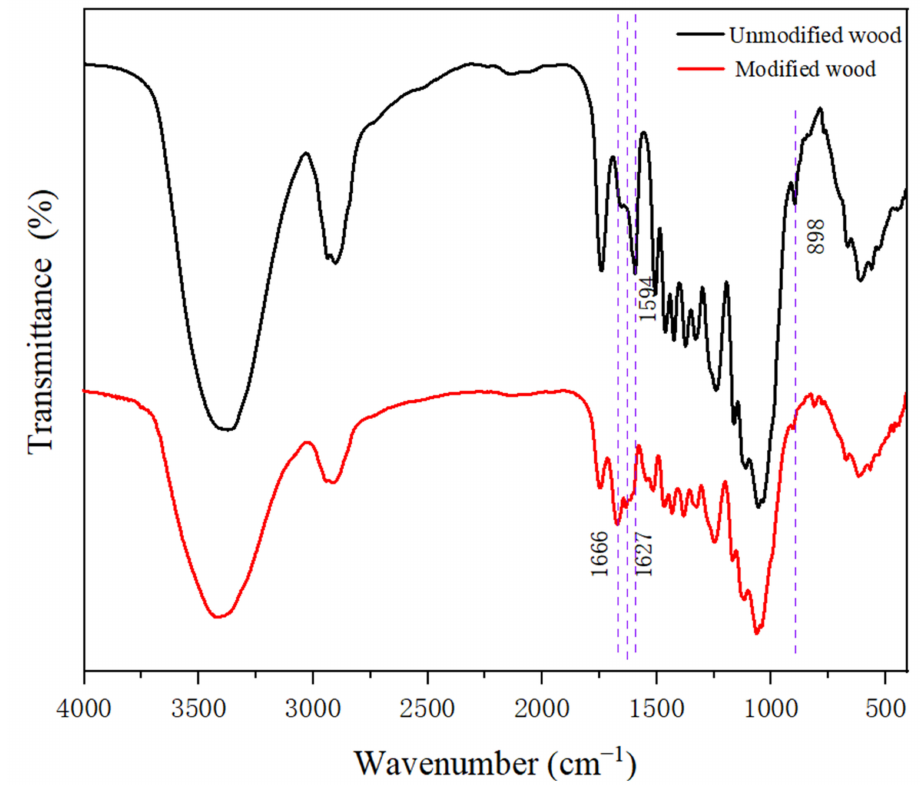
Figure 4. The FTIR spectra of the treated wood and untreated